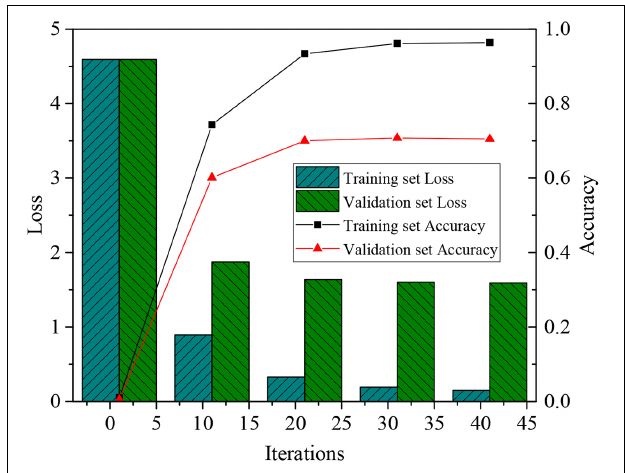
FIGURE 4 | Accuracy and loss value of recognition results based on the gray-scale features.